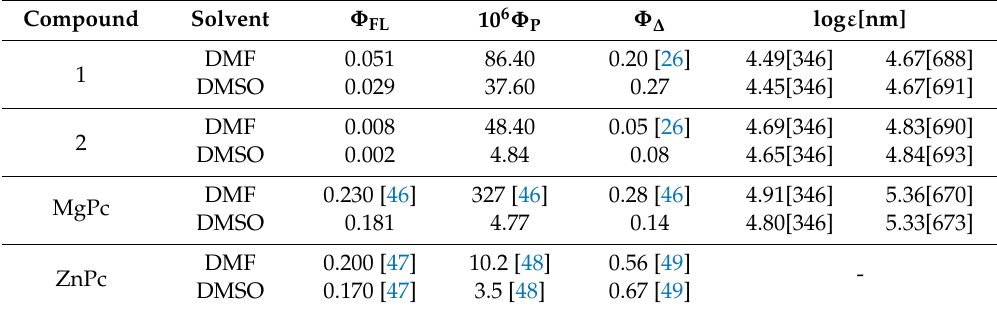
Figure 5. The UV-vis absorption spectra in DMF of ( a ) DPBF decomposition during irradiation of the mixture of 1 and DPBF within 540 s; ( b ) photobleaching of MgPc within 600 s. Table 1. Fluorescence, photodegradation, singlet oxygen formation quantum yields and log of the molar absorption coefficient of 1, 2 and MgPc.